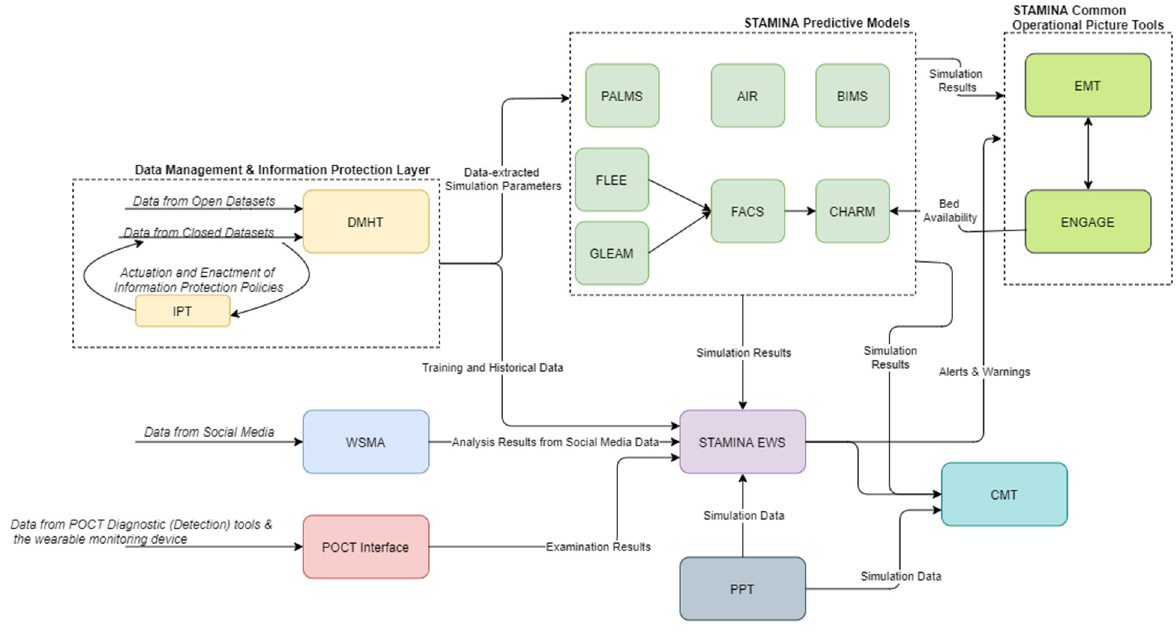
Figure 1. High-Level Architecture.